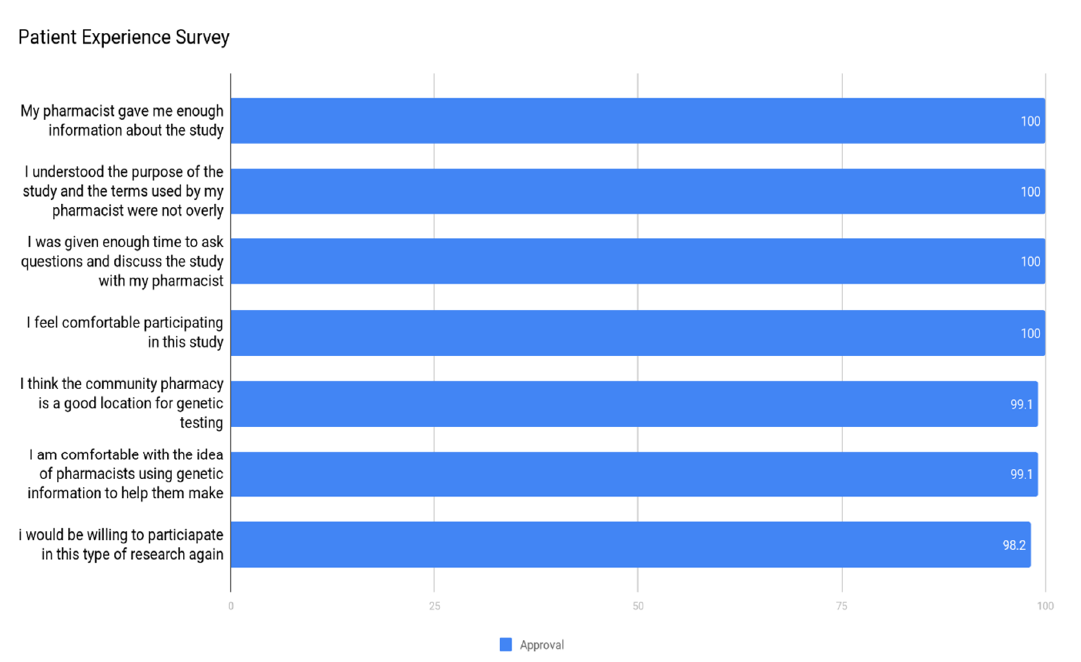
Figure 2. Patient experience survey. All results, 98.2–100% strongly agree/agree, N = 111.